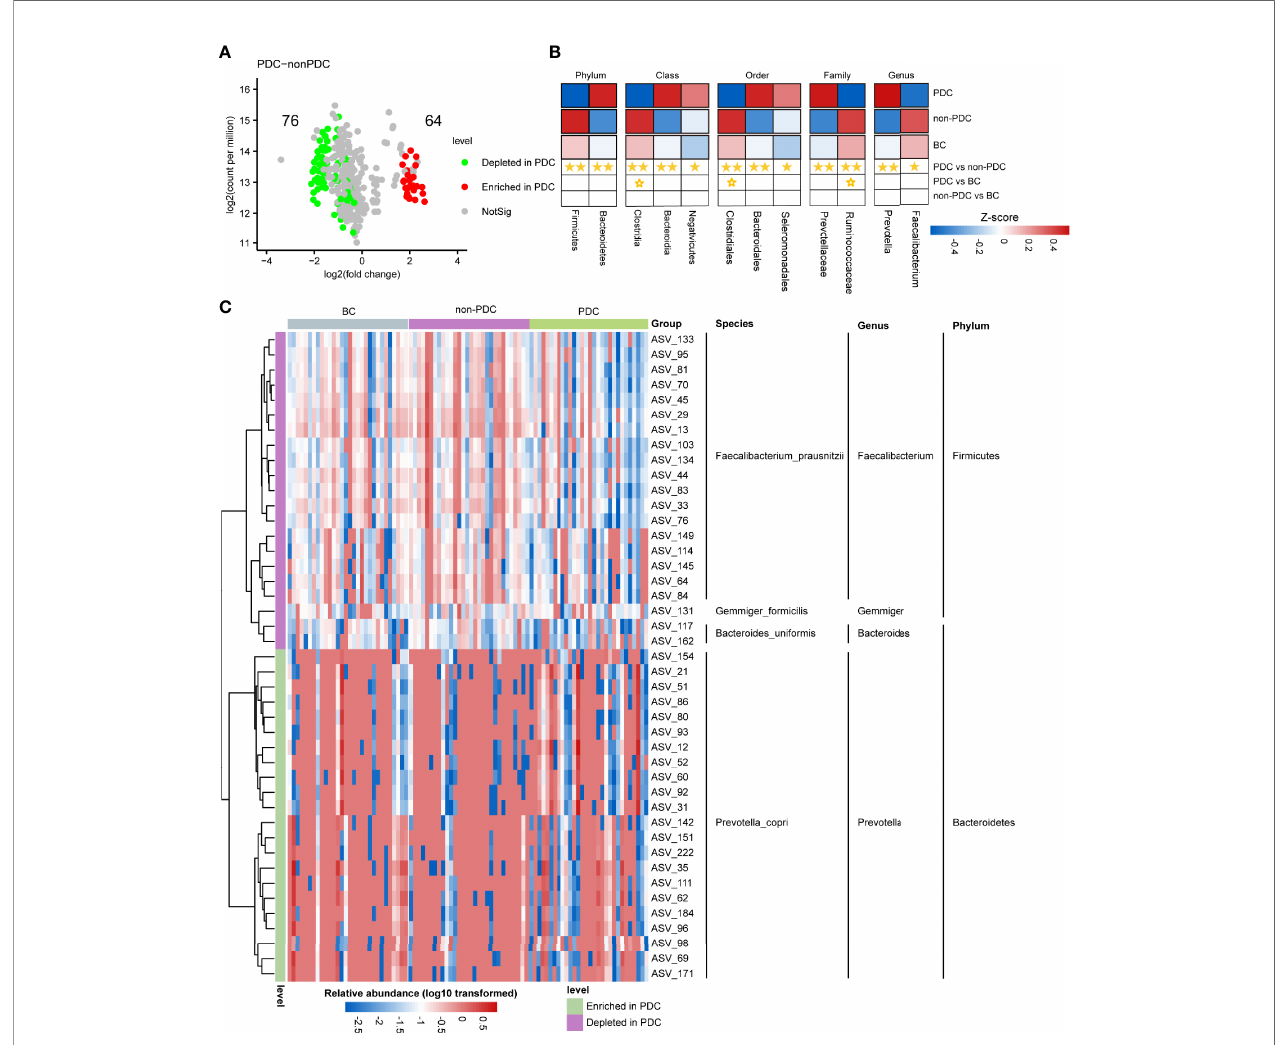
FIGURE 3 | Alterations in the composition of fecal microbiota associated with PDC. (A) A volcano plot demonstrating differential ASVs between the PDC group and the non-PDC group. (B) A heatmap illustrating the relative abundance of PDC-associated taxa across the three groups (P value <0.05 by Wilcoxon rank sum test) and adjusted p<0.1 by FDR). The abundance pro fi les are transformed into Z scores by subtracting the average abundance and dividing the standard deviation of all samples. Z score is negative (shown in blue) when the row abundance is lower than the mean. Taxa at P value <0.01 are marked with two solid stars, P value <0.05 with one solid star, P value <0.1 with hollow star. (C) Heat map of the relative abundance of 43 ASVs with relative abundance greater than 0.1% that were signi fi cantly different between PDC group and non-PDC group (A threshold of P < 0.05 and FDR < 0.05 calculated by Wilcoxon rank sum test). ASVs are shown from lower abundance (in blue) to higher abundance (in red). All 43 ASVs were assigned to phyla, genera and